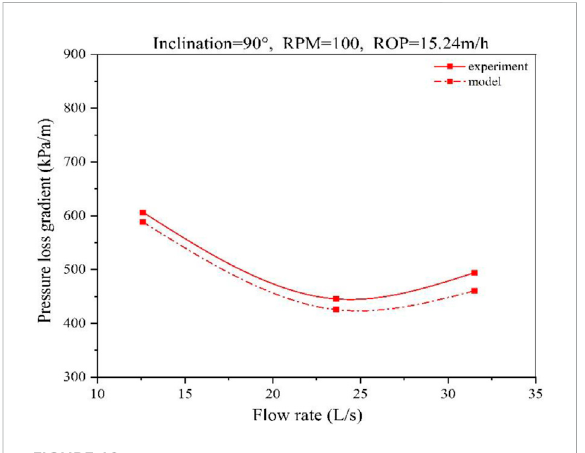
FIGURE 10 Pressure loss gradient at 90 ° , 15.24 m/h, and 100 RPM.